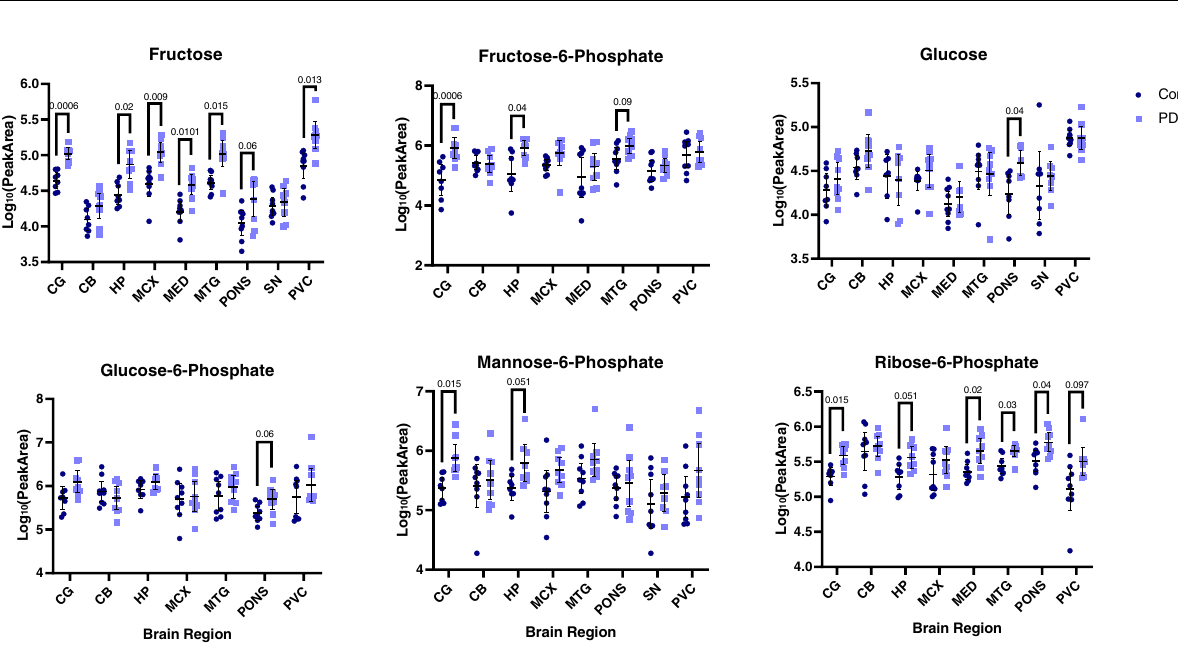
Fig. 3 Glucose pathway metabolites in the PDD brain. Data shown are mean log 10 peak area data ±95% con fi dence intervals. C control, PDD Parkinson ’ s disease dementia. Q values are shown for signi fi cant discoveries determined by multiple t -tests corrected by 10% FDR. CB cerebellum, CG cingulate gyrus, HP hippocampus, MCX motor cortex, MED medulla oblongata, MTG middle temporal gyrus, PVC primary visual cortex, SN substantia